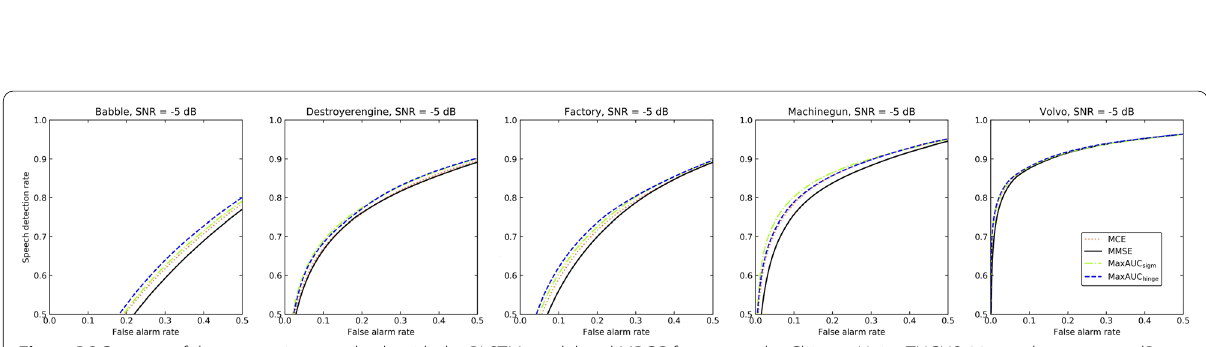
Fig. 4 ROC curves of the comparison methods with the BLSTM model and MRCG feature on the Chinese Noisy‑THCHS‑30 test dataset at − 5